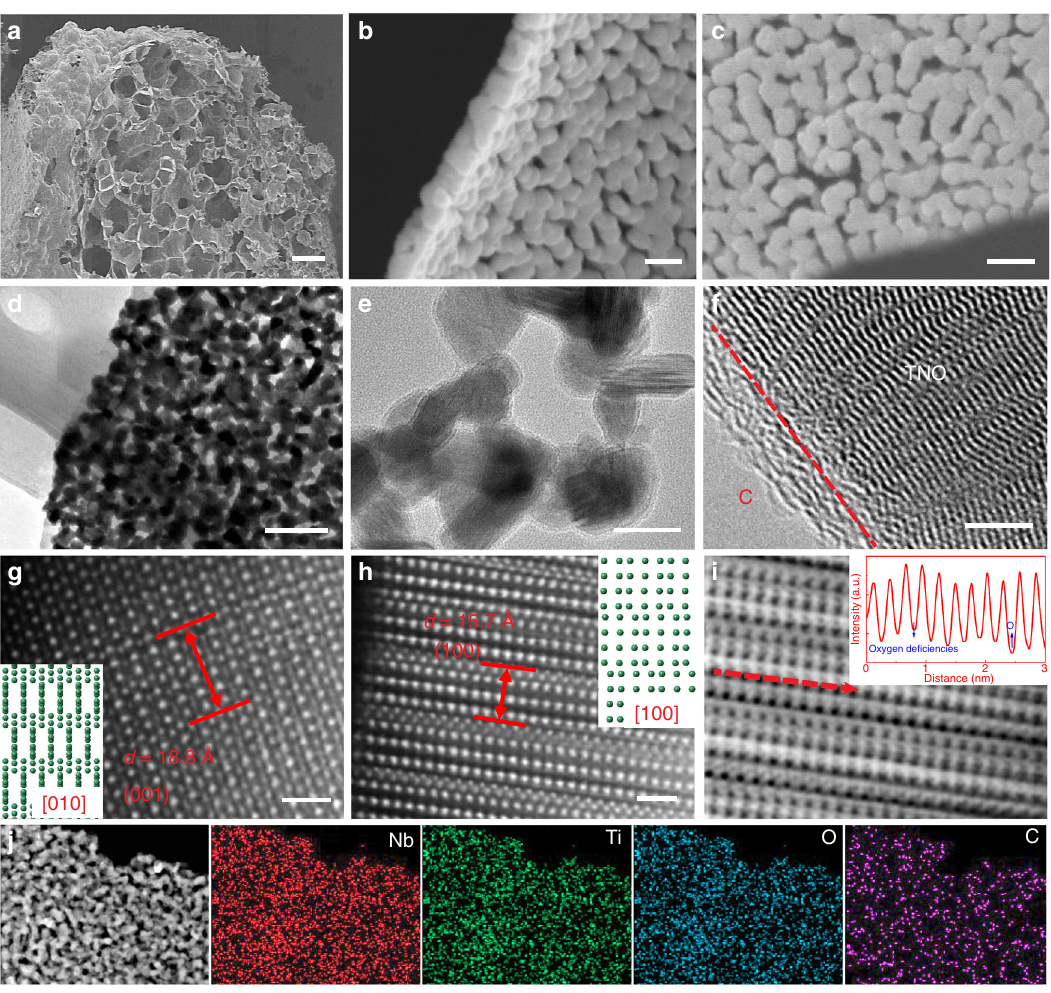
Fig. 1 Synthesis and characterization of all products. a SEM images of hierarchical porous TNO − x @C 3 . b TNO − x @C 3 nanosheets. c TNO − x @C 3 from top view. d TEM images of TNO − x @C 3 . e TEM images of TNO − x @C 3 . f HRTEM images of TNO − x @C 3 . g HAADF images of TNO − x @C 3 . h HAADF images of TNO − x @C 3 . i ABF images of TNO − x @C 3 . j EDS elemental mapping images of Nb, Ti, O, and C in the TNO − x @C 3 composite. Scale bars: a 200 μ m, b ,